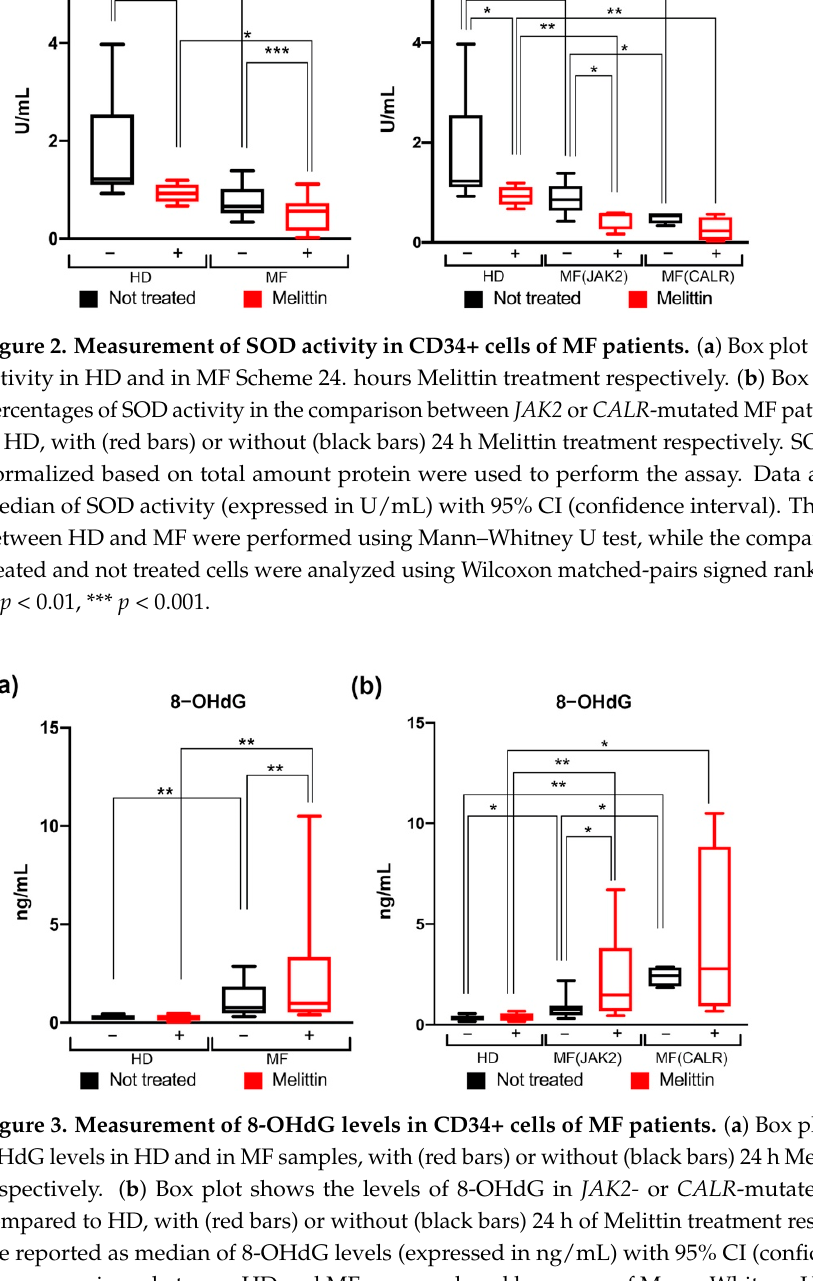
Figure 2. Measurement of SOD activity in CD34+ cells of MF patients. ( a ) Box plot shows the SOD activity in HD and in MF Scheme 24. hours Melittin treatment respectively. ( b ) Box plot shows the percentages of SOD activity in the comparison between JAK2 or CALR -mutated MF patients com- pared to HD, with (red bars) or without (black bars) 24 h Melittin treatment respectively. SOD ac- tivity was normalized based on total amount protein were used to perform the assay. Data are re- ported as median of SOD activity (expressed in U/mL) with 95% CI (confidence interval). The com- parisons between HD and MF were performed using Mann–Whitney U test, while the comparisons between treated and not treated cells were analyzed using Wilcoxon matched-pairs signed rank test.